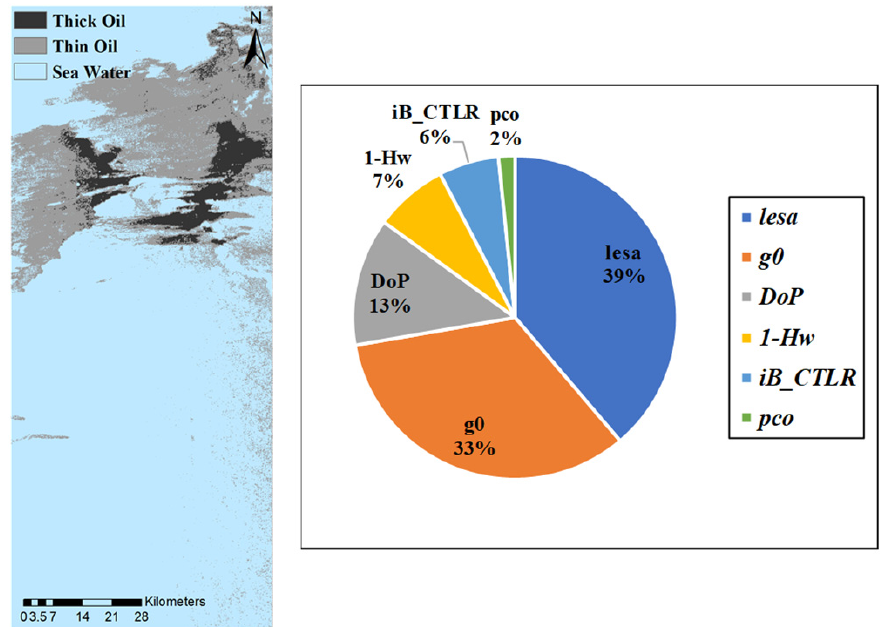
Table 7. Classification accuracies of random forest classifier in Case 5.